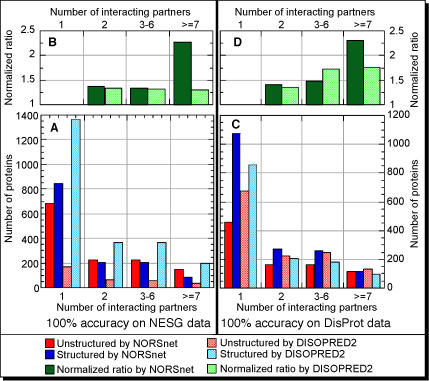
Unstructured Regions Overrepresented in Protein–Protein Hubs of the WormWe ran both NORSnet and DISOPRED2 on worm proteins that are involved in protein–protein interactions (as identified by yeast two-hybrid [66]). The number of proteins that are predicted to be either unstructured or well-structured is plotted against the number of interacting partners for two different thresholds of reliability of the two methods: (A) and (B) were compiled for thresholds at which both methods maintained 100% accuracy for the NESG data (Figure 4), while (C) and (D) were compiled for 100% accuracy on DisProt (Figure 3). Since the number of observed interaction partners falls off dramatically, we had to group the data into bins of roughly equal sizes (x-axes). (A) and (C) show the results for the number of proteins predicted in each bin of interaction partners, while (B) and (D) show the normalized ratios to zoom into the difference between unstructured and structured proteins in each bin. These ratios were compiled as Ratio(bin) = {#unstructured(bin) / #structured(bin)} / {#unstructured(1) / #structured(1)}. As all ratios are greater than 1, proteins with more than one interaction partner have more unstructured regions than proteins with one partner.(A) These graphs were compiled with the reliability threshold at which each method achieved 100% accuracy by the NESG data (Figure 4). Overall, this threshold resulted in NORSnet (filled bars) predicting many more proteins with unstructured regions than DISOPRED2 (hatched bars). The difference was particularly relevant for proteins with more interacting partners.(B) NORSnet (filled, dark green) predicted many more unstructured regions in proteins with seven or more interaction partners than did DISOPRED2 (hatched, light green).(C) For the thresholds at which both methods achieved 100% accuracy on the DisProt dataset, DISOPRED2 identified more proteins with unstructured regions than did NORSnet. In contrast to the situation for the NESG set (A), the difference was not as significant for promiscuous proteins (ten or more partners).(D) Although NORSnet (filled, dark green) predicted as many unstructured as structured regions in hubs (seven or more), this ratio was significantly smaller than the one for proteins with a single interaction partner. In other words, even on this dataset NORSnet picked up a much stronger overrepresentation of unstructured regions in hubs than did DISOPRED2 (hatched, light green).